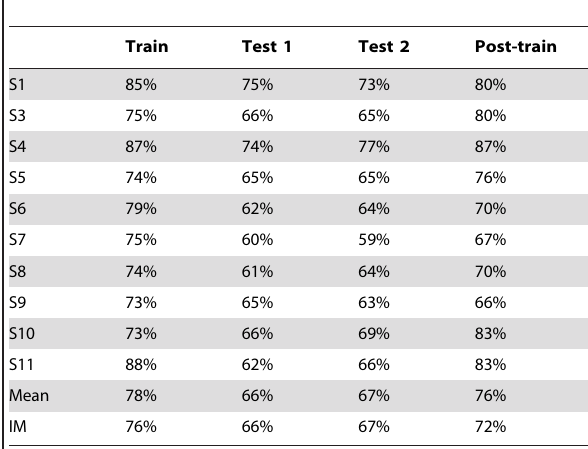
Table 1. Classification